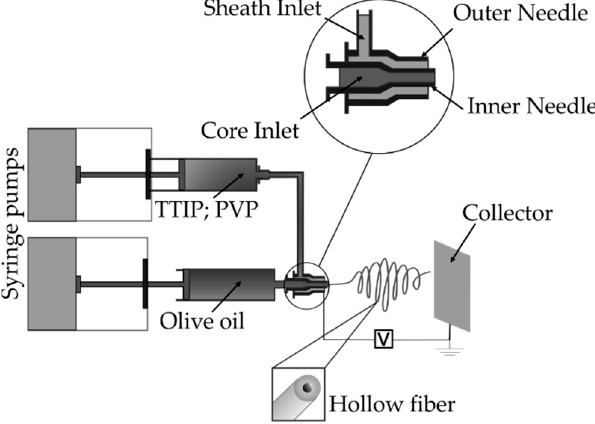
Figure 7. Schematic of co-axial electrospinning to produce Zn-doped TiO 2 HF.